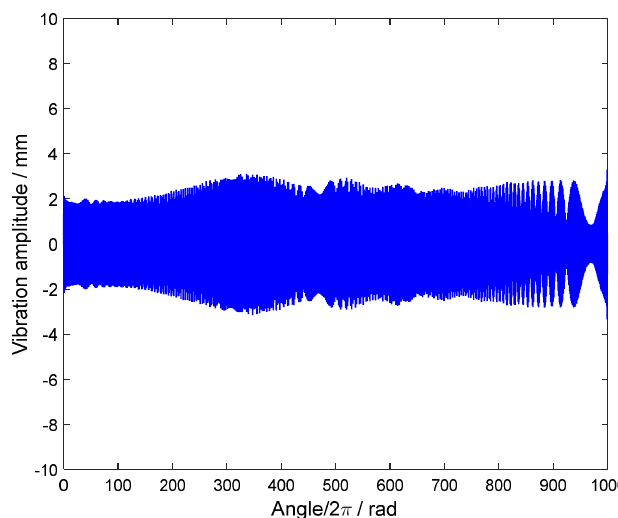
Figure 13. The interpolation function in Equation (22).